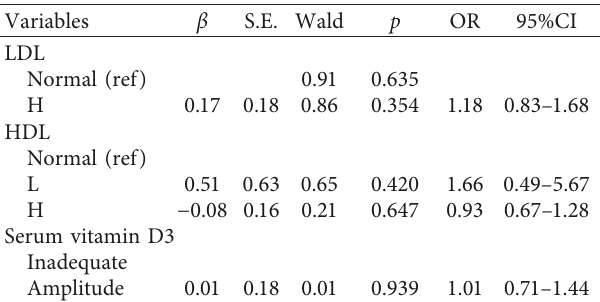
TPOAb: thyroid peroxidase antibody; TgAb: thyroglobulin antibody; “+”: positive autoantibody; “ − ”: negative autoantibodies; LDL: low-density li- poprotein; HDL: high-density lipoprotein. “ ∗ ” and bold text represent statistical significance. “ ∗ ” and bold text represent statistical